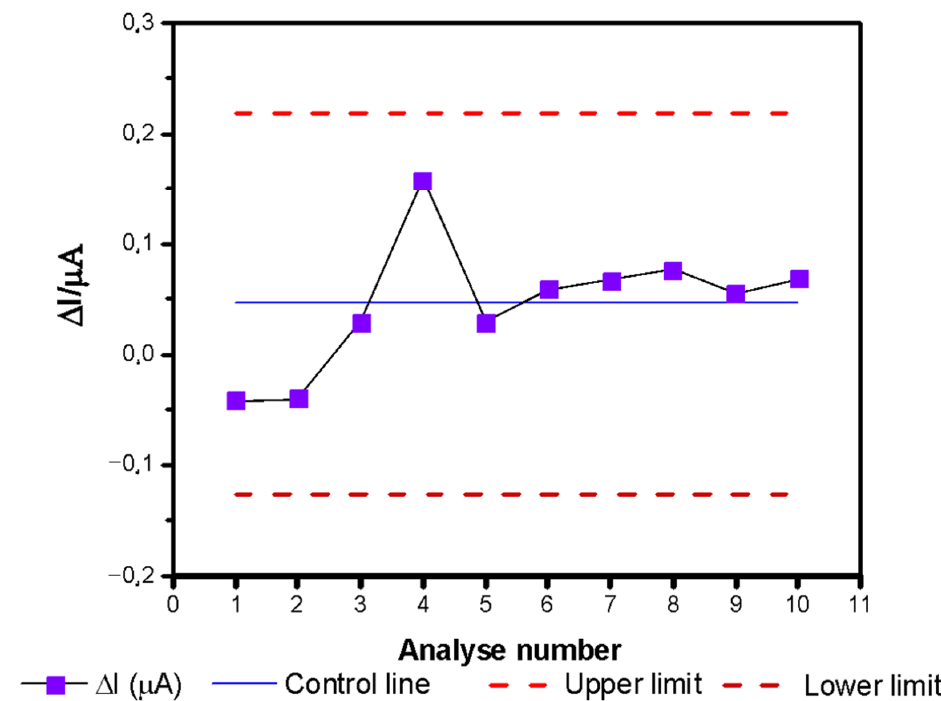
Figure 8 . Statistical control chart for monitoring the biosensor stability. Figure 8. Statistical control chart for monitoring the biosensor